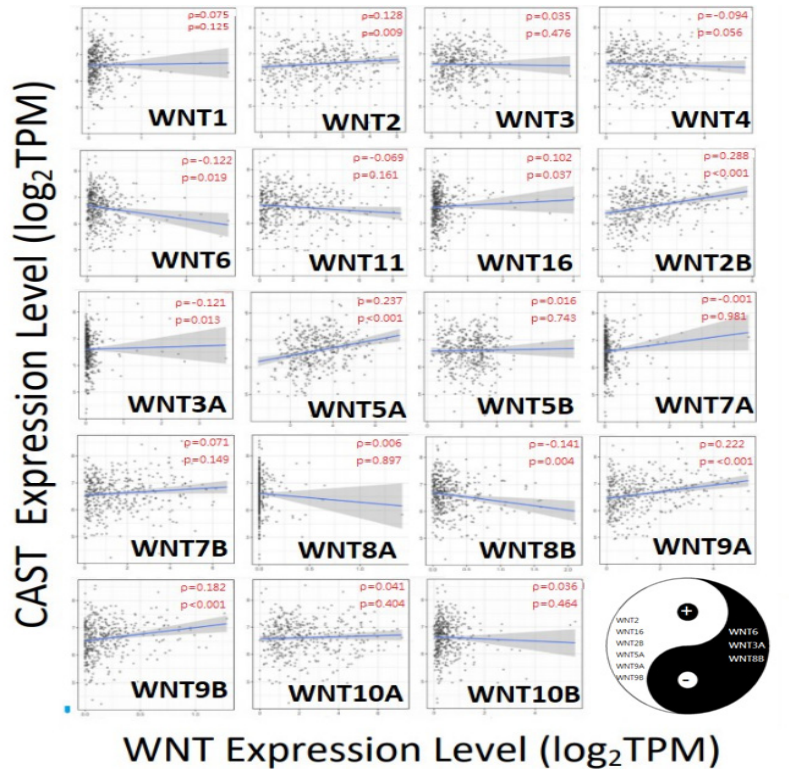
Figure 6. Correlation between CAST and the WNT family. +: significant positive correlation, WNT2 (rho = 0.128; p -value = 0.009); WNT16 (rho = 0.102; p -value = 0.037); WNT2B (rho = 0.288; p -value < 0.001); WNT5A (rho = 0.237; p -value < 0.001); WNT9A (rho = 0.222; p -value < 0.001); WNT9B (rho = 0.182; p -value < 0.001). − : signi fi cant negative correlation, WNT6 (rho = − 0.122; p -value = 0.019); WNT3A (rho = − 0.121; p -value = 0.013); WNT8B (rho = − 0.141; p -value = 0.004).